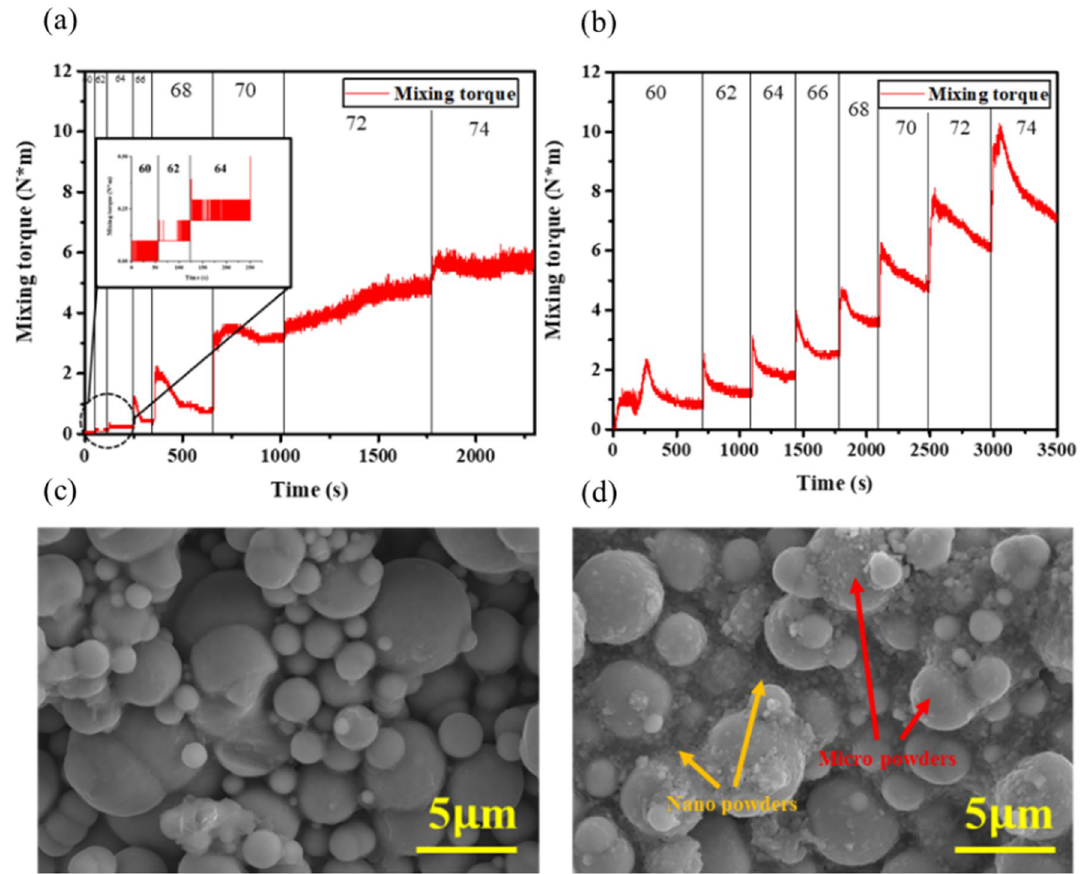
Figure 4. Mixing torques measurement results ranging from 60 to 74 vol.% of ( a ) monomodal and ( b ) trimodal feedstocks. SEM images of 74 vol.% of ( c ) monomodal and ( d ) trimodal feedstocks.